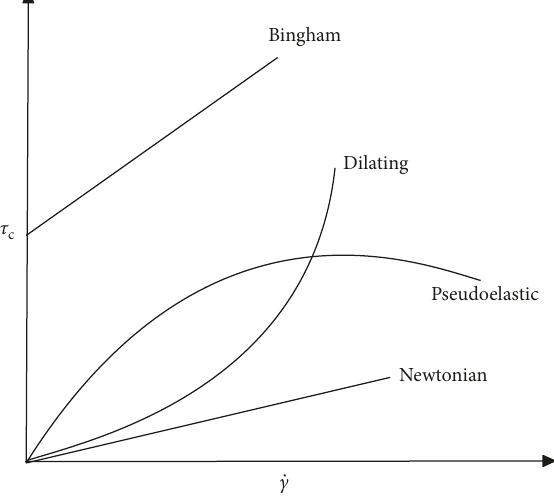
Figure 11: Fluid